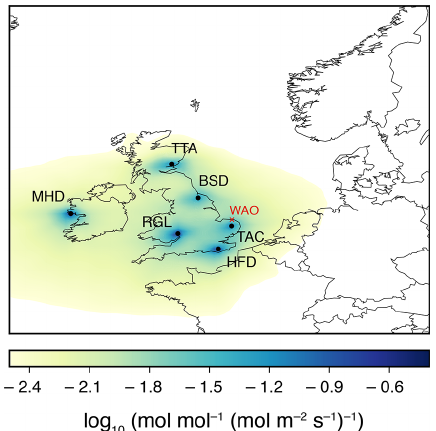
Figure 1. Mean annual NAME footprint for 2014, for each of the six sites. MHD: Mace Head; RGL: Ridge Hill; HFD: Heathfield; TAC: Tacolneston; BSD: Bilsdale; TTA: Angus. WAO shows the location of the Weybourne Atmospheric Observatory, where data have been used to validate the results but have not been included in the inversion (the mean footprint from this station is not plotted).